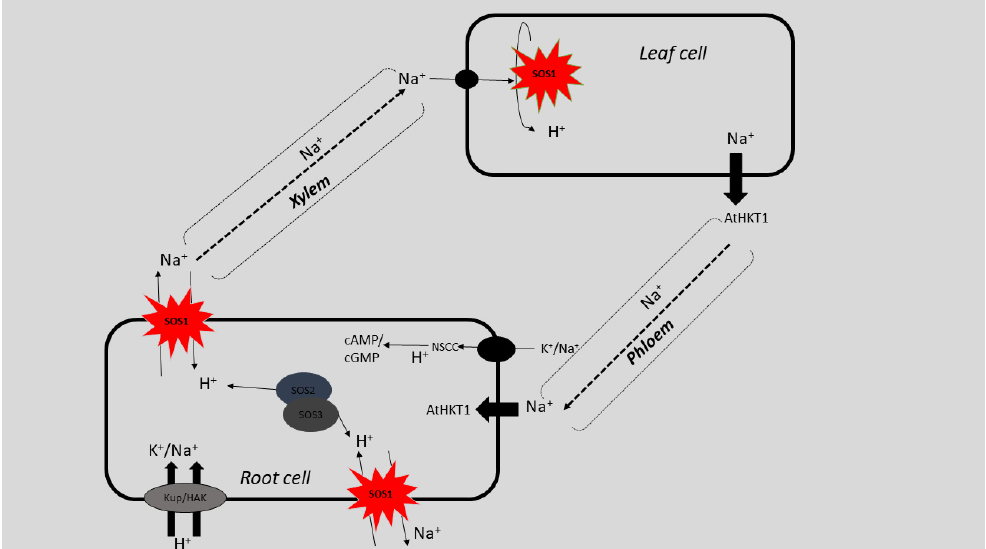
Figure 2. Na + transport at the level of the whole plant. Sodium ions can enter the cells of the root through non-selective channels (NSCCs) not formally identified at the molecular level, some of which appear to be inactivated by cyclic nucleotides (cAMP and cGMP; Maathuis and Sanders 2001), transporters HKT and high concentration of Na, KUP / HAK carriers. Na excretion cell roots to the soil solution or to the vessels of the xylem involve the antiport H + / Na + SOS1, whose activity is regulated by the SOS3 CBL protein associated with the SOS2 kinase of the HKT conveyors allow desalinization of xylem sap and phloem loading in Na + at the leaf